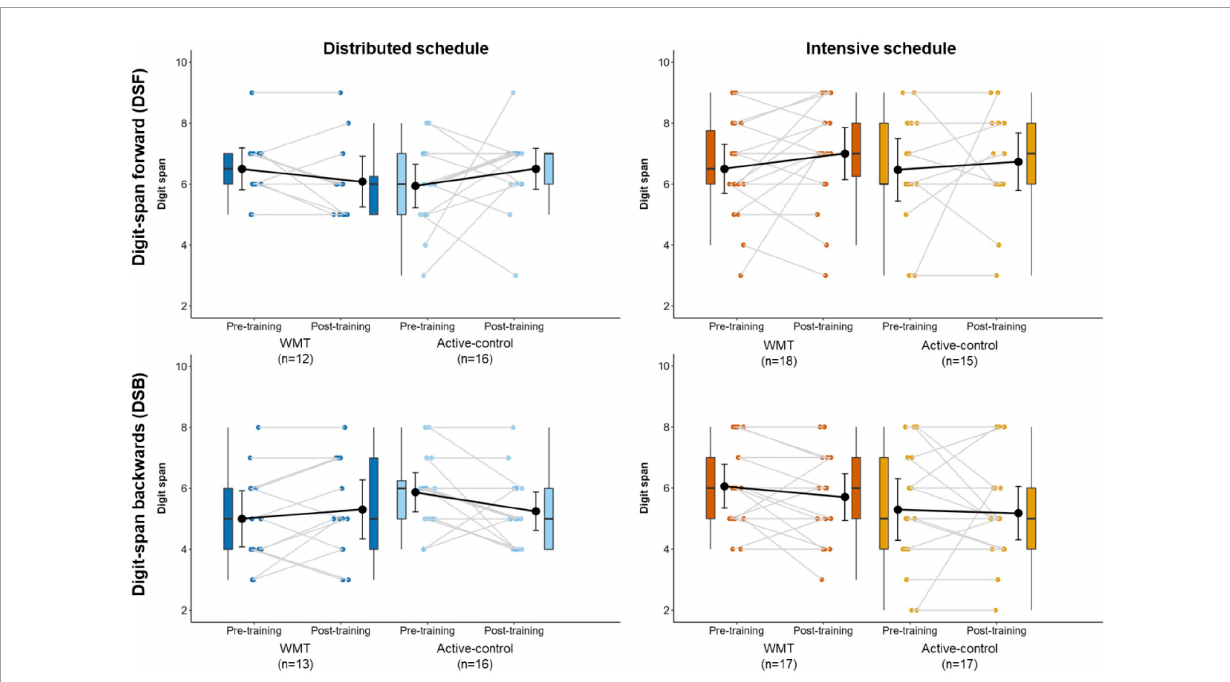
FIGURE6 Performance on the DSF (top) and DSB (bottom) near transfer tasks at pre-training and post-training, separately for distributed groups (left) and intensive groups (right) . Box plots represent the median (crossbars), 1st and 3rd quartile (upper and lower hinges, respectively), and the range of the data (whiskers). Single data points represent individual participants. Black circles and error bars show the group mean and 95% confidence interval.